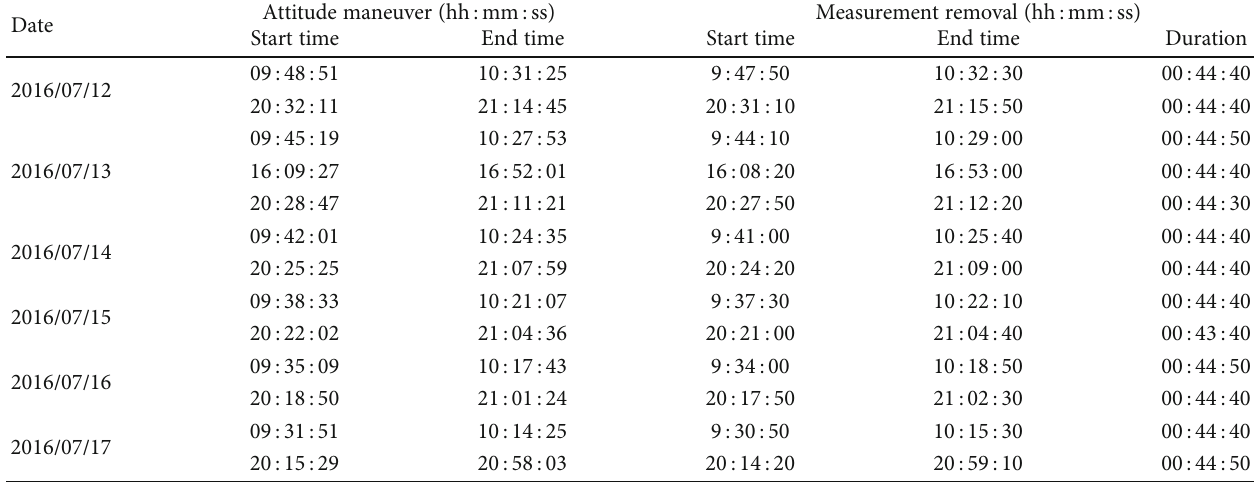
Table 3: Start and end time for the actual attitude maneuvers and the removed measurements.